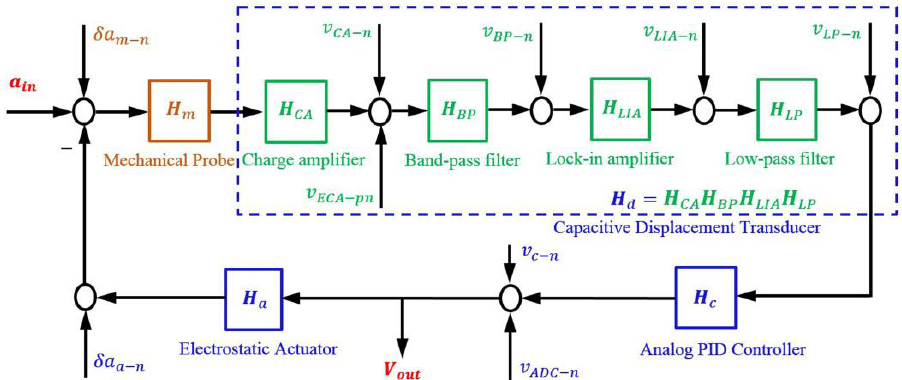
Figure 4. Noise model of the accelerometer. 𝑎 𝑖𝑛 denotes the external acceleration, and 𝑉 𝑜𝑢𝑡 represents the output voltage of accelerometer.